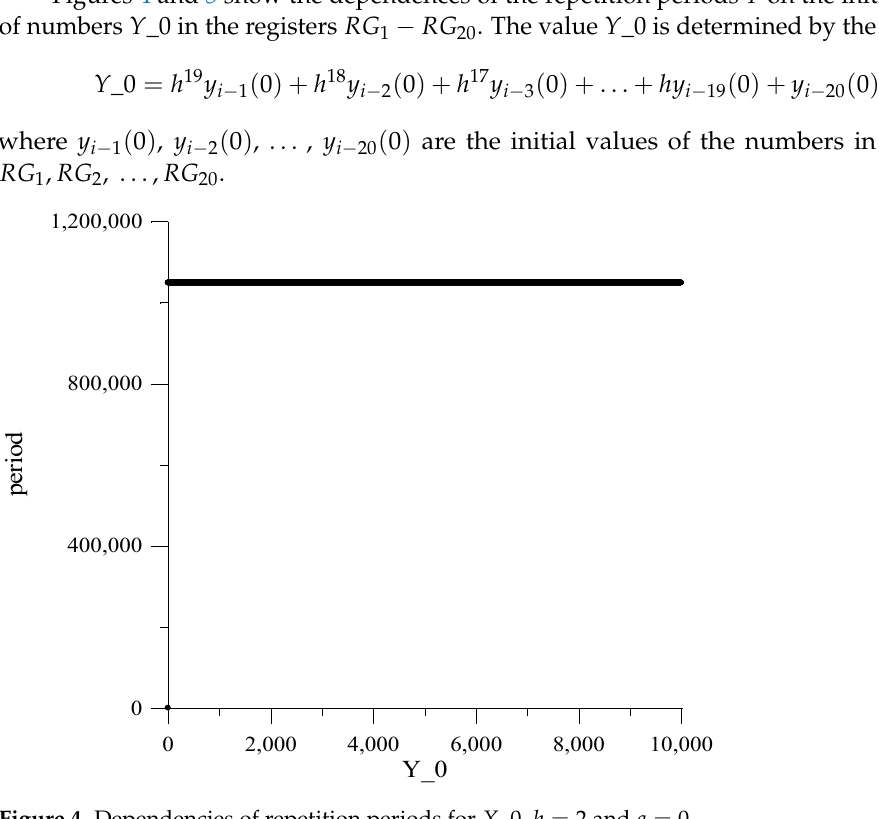
Figure 4. Dependencies of repetition periods for X _0, h = 2 and a =